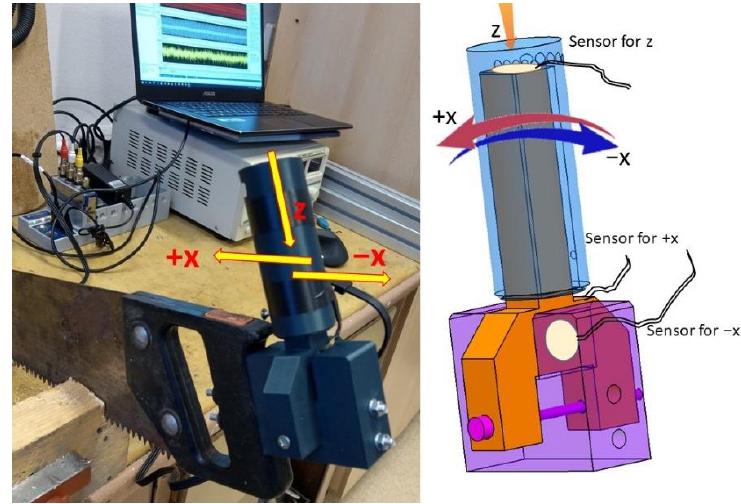
Figure 3. Equipment for determining push-pull (shear) and vertical (z axis) forces. Five-second-long signals were captured with a frequency of 2 kHz. Approximately equal values were found for the movements in the longitudinal direction for pushing and pulling the saw (forwards and backwards), and for the vertical direction an approximately constant force was observed.